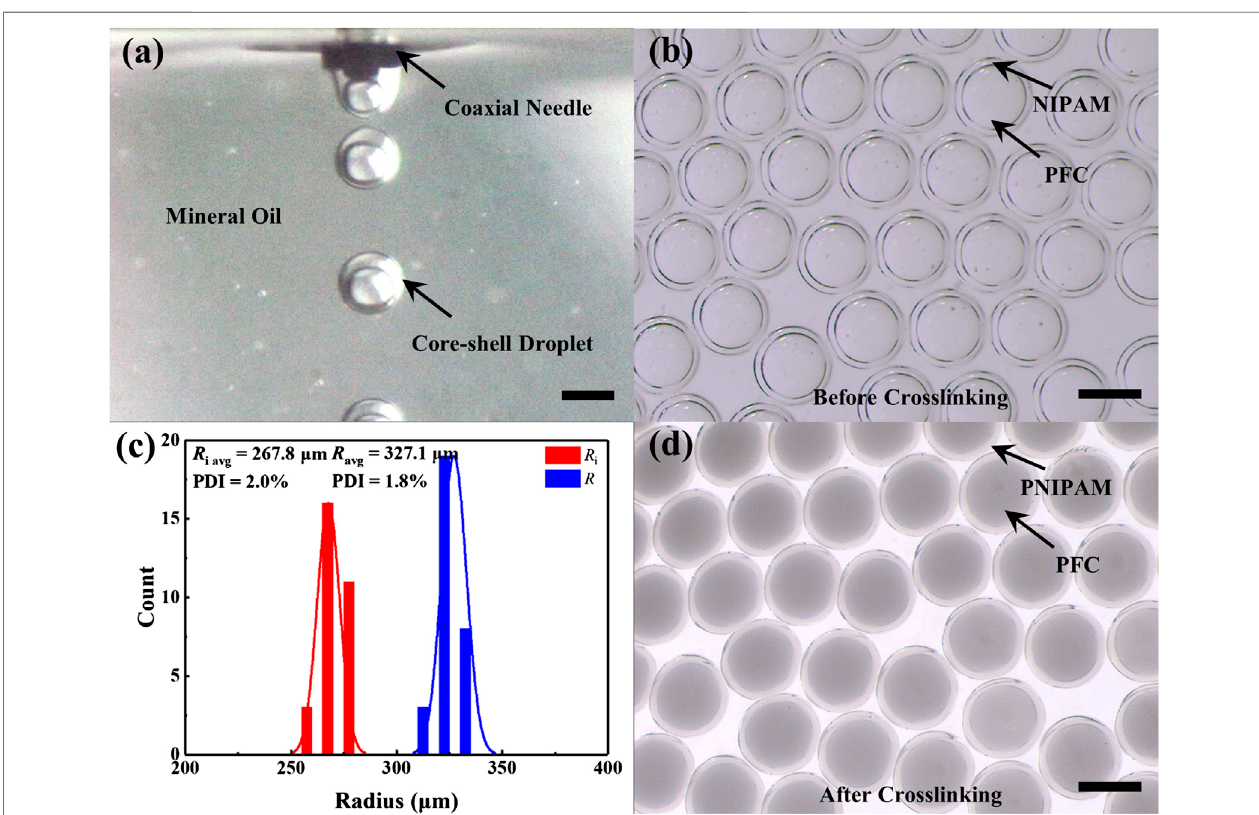
FIGURE 2 | The preparation of PFC-loaded NIPAM double emulsions. (A) Real-time CIS process during core-shell droplets formation. (B) Optical microscopic imageoftheproducedPFC-loadedNIPAMdoubleemulsionsdispersedinmineraloilbeforecrosslinking( Q o (cid:1) 15 μ L/min, Q i (cid:1) 15 μ L/min, f (cid:1) 4 Hz). (C) Sizedistributions ofthedoubleemulsionsinnercoreandoutershellin (B) . (D) Thechangeofthedoubleemulsionmorphologyaftercrosslinking( Q o (cid:1) 15 μ L/min, Q i (cid:1) 15 μ L/min, f (cid:1) 4 Hz). Scale bar: 500 μ